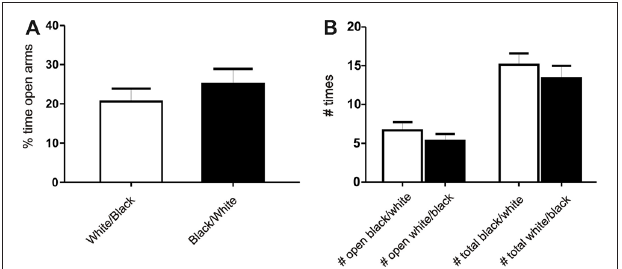
FIGURE 2 | Exposure to the white compartment does not produce an anxiogenic state in rats. Animals were conditioned following the same protocol as before. Immediately after exposition to the white or black compartment, animals were tested on a Plus Maze paradigm. (A) Percentage of time spent in the open arms. There is no significant differences between groups ( p > 0.05, n = 10). (B) Number of entries in the open arms and total entries into both arms. There is no significant differences in any of the variables studied ( p > 0.05, n =